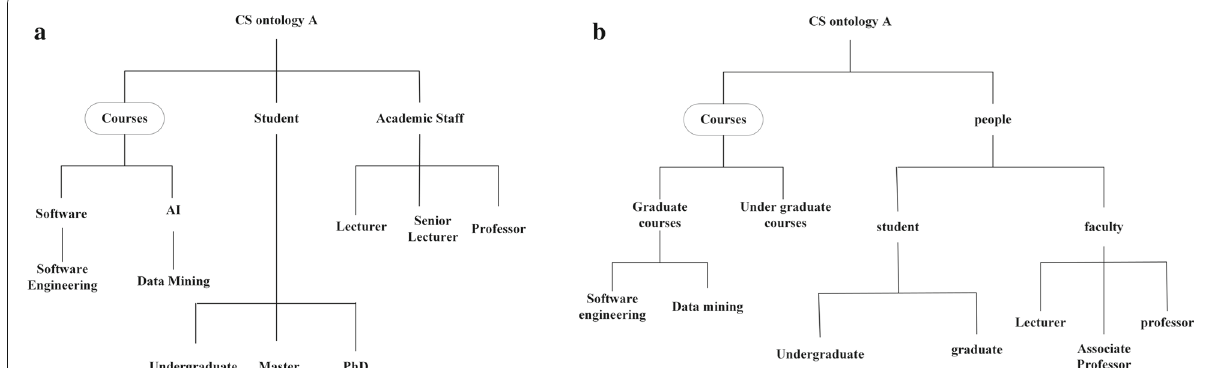
Fig. 1 University ontologies O 1 and O